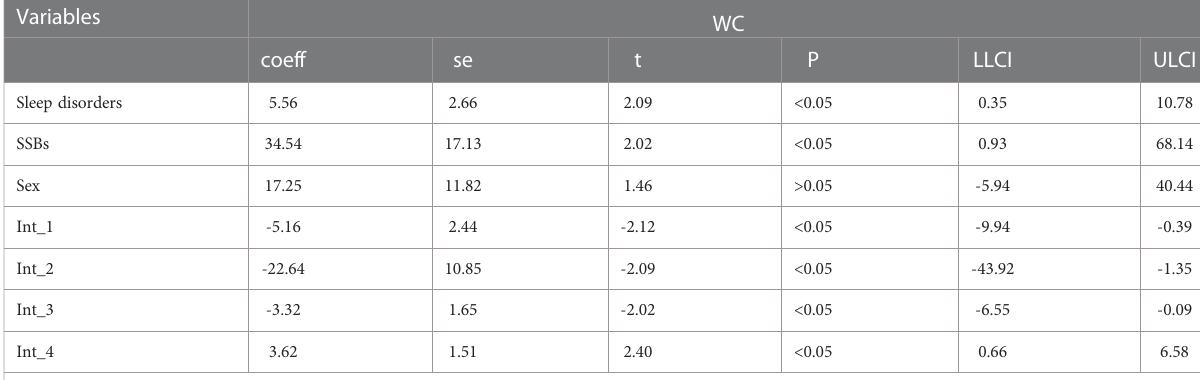
TABLE 3 The moderation analysis between SSBs, Sleep disorders, HbA1c and WC. Variables